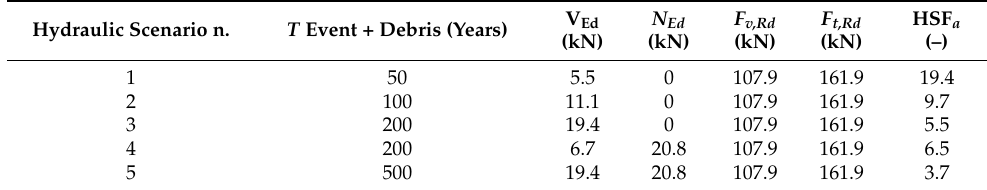
anchor bolt resistance when subjected to various hydraulic actions. Table 2. Comparison between resistances and acting forces on each steel anchor depending on the return period T